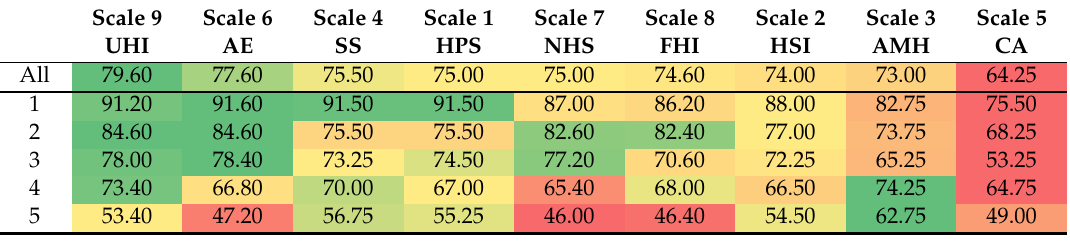
Table 3. Maximum percentage